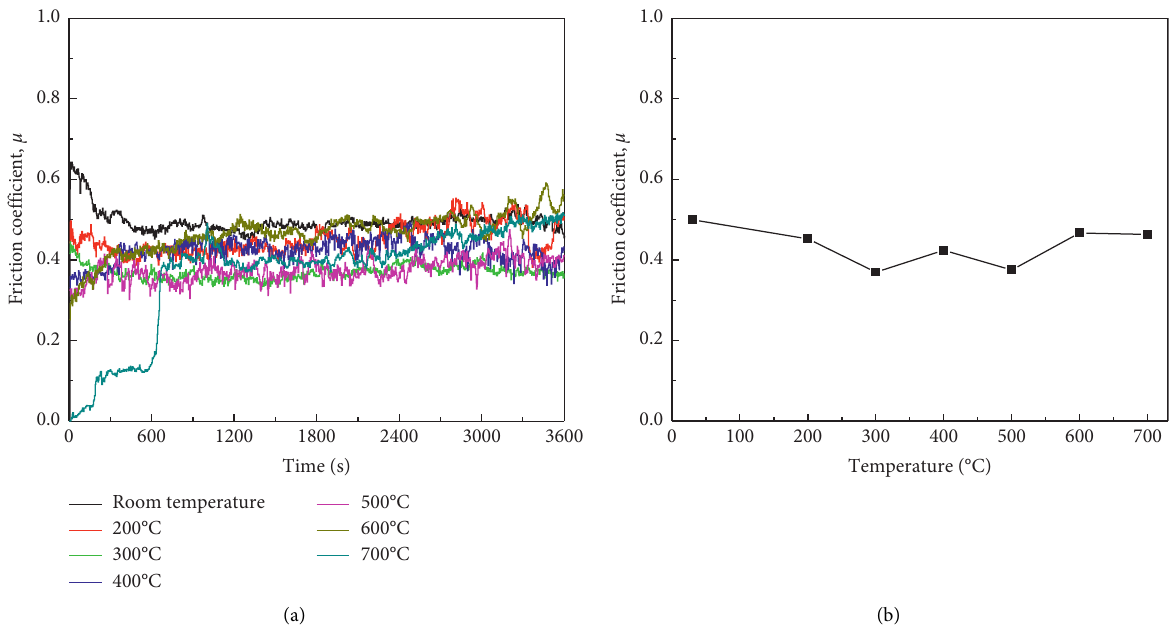
Figure 12: Friction coefficients of S2 coating at various temperatures: (a) friction coefficient from room temperature to 700 ° C; (b) average coefficient.